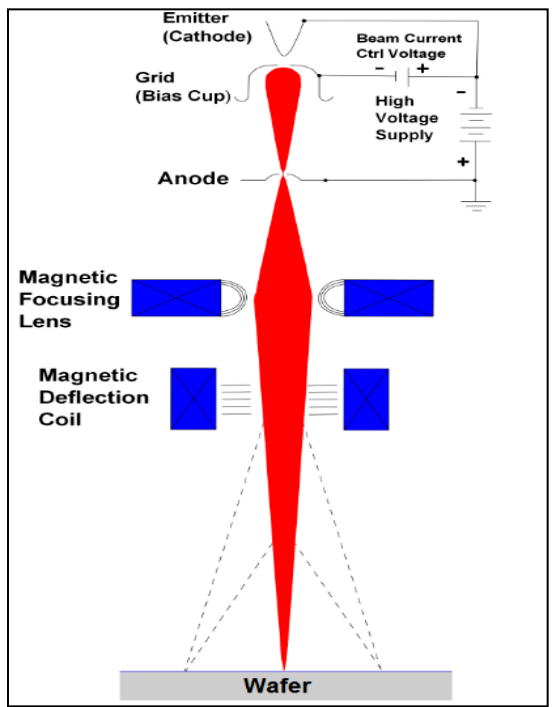
Figure 3. Schematic of e-beam generation projection to a wafer where the principle of e-beam inspection tool is depicted.